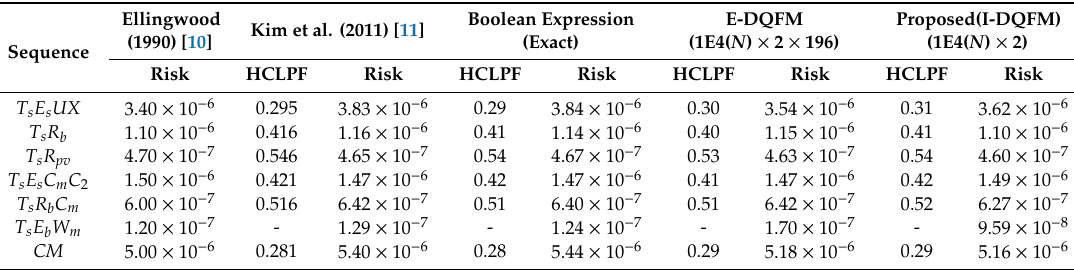
Table 4. Mean seismic risk for “LGS NPP”: Independent